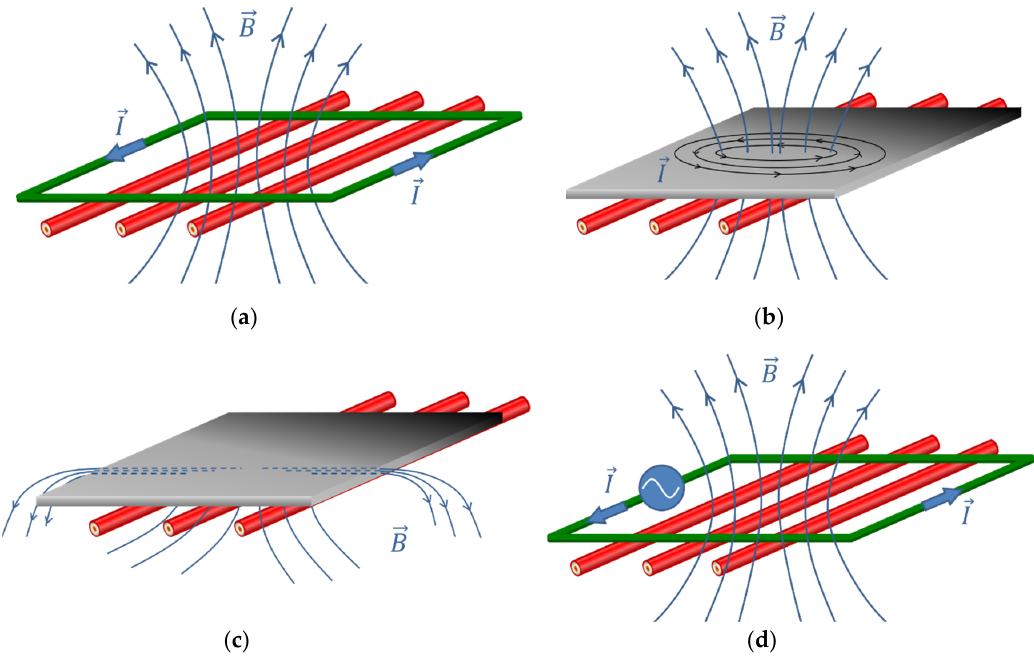
Figure 5. Passive and active techniques as follows: ( a ) Passive loop, ( b ) conductive shield, ( c ) Figure ferromagnetic shield, and ( d ) active loop.